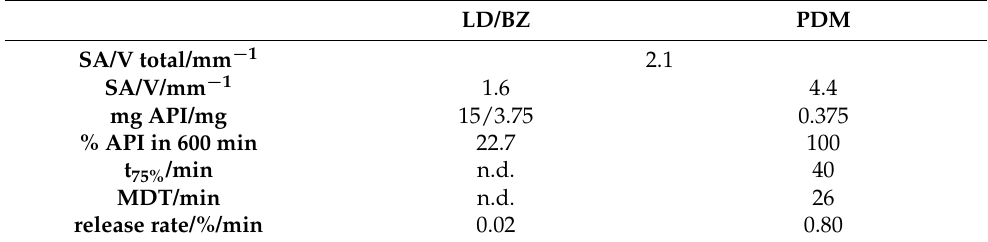
Figure 11. ( Left ): release profile of polypill design MiniTab; modified basket apparatus, 1000 mL 0.1 N HCl, 50 rpm, 37.0 ± 0.5 °C, x ± s; n = 3. ( Right ): Image of MiniTab: red: PDM-PVA, blue: LD/BZ- EVA. Table 10. Structure and release properties of MiniTab.